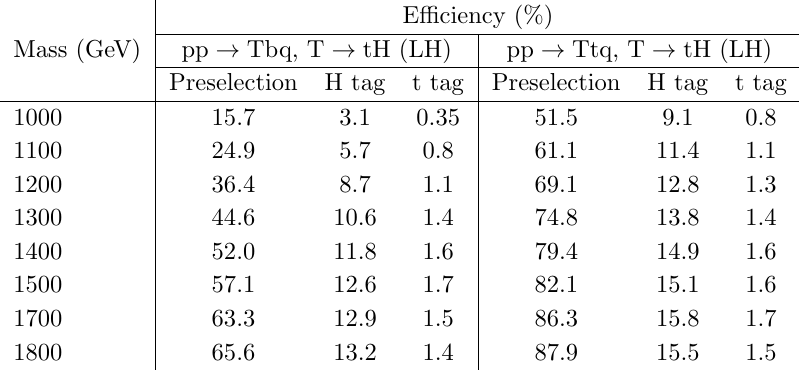
Table 1 . The signal e(cid:14)ciencies for successive event selections for the pp ! Tbq and pp ! Ttq models with left-handed couplings. The preselection criteria are more e(cid:14)cient for the pp ! Ttq process compared to the pp ! Tbq process owing to the larger number of jets, and hence a higher H T per event, in the former. This is more pronounced for low T quark mass samples, where the H T is close to the trigger threshold of 800